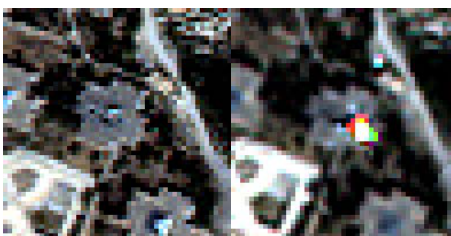
Figure 6. Figure 5. Image details for the two images related to the only false alarm in the lower center of Fig. 5. This is due to an artefact present in the second image (©European Space Imaging /